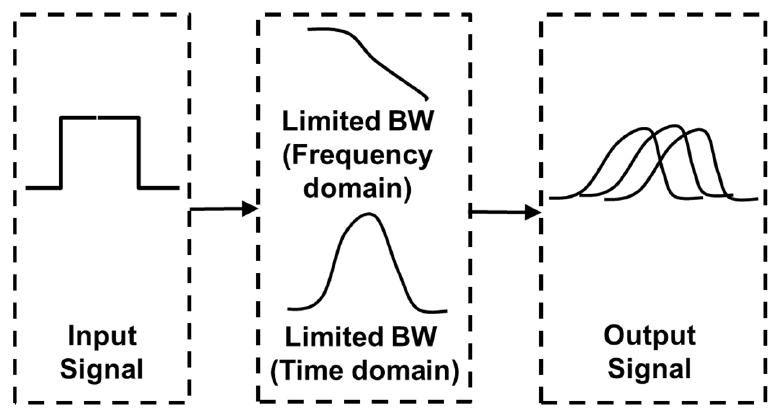
Figure 5. Simulated path loss versus distance in free-space channel and water channel.